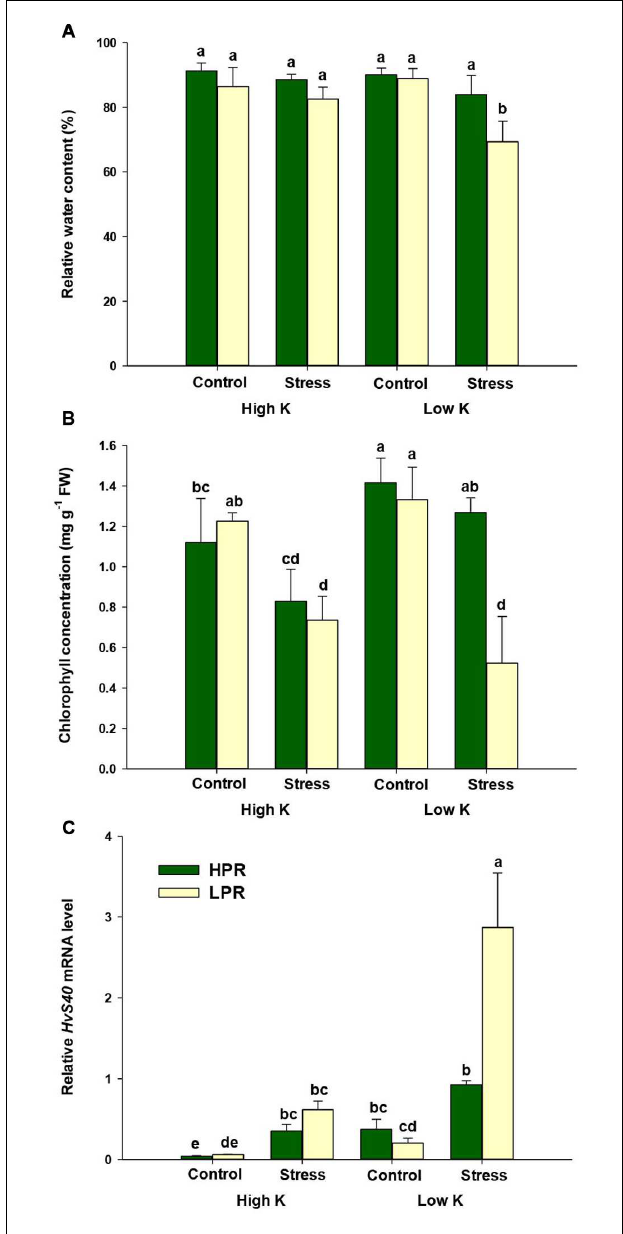
FIGURE 1 | Influence of K supply on relative water content and senescence parameters in flag leaves of barley during terminal drought stress. (A) Relative water contents (RWCs), (B) chlorophyll concentrations, and (C) relative HvS40 mRNA levels in flag leaves of the